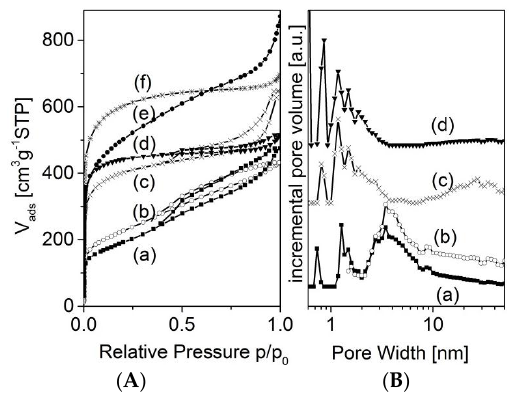
Figure 6. ( A ) Nitrogen adsorption isotherms of the samples 1173-0M (a); 873-0M (b); 1173-12M (c); 873-12M (d); 1173-20M (e); 873-20M (f); and selected pore size distribution functions ( B ).